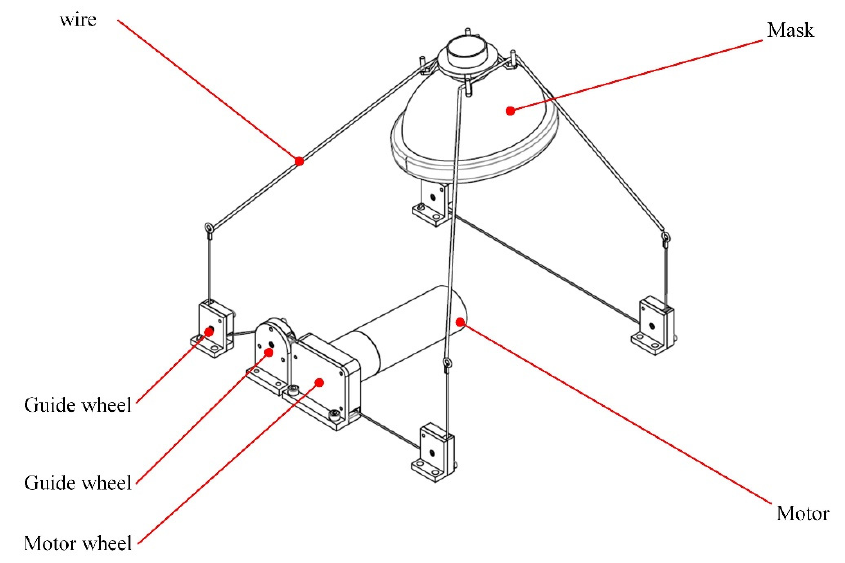
Figure 3. The structural profile of the proposed mask-fastening module.